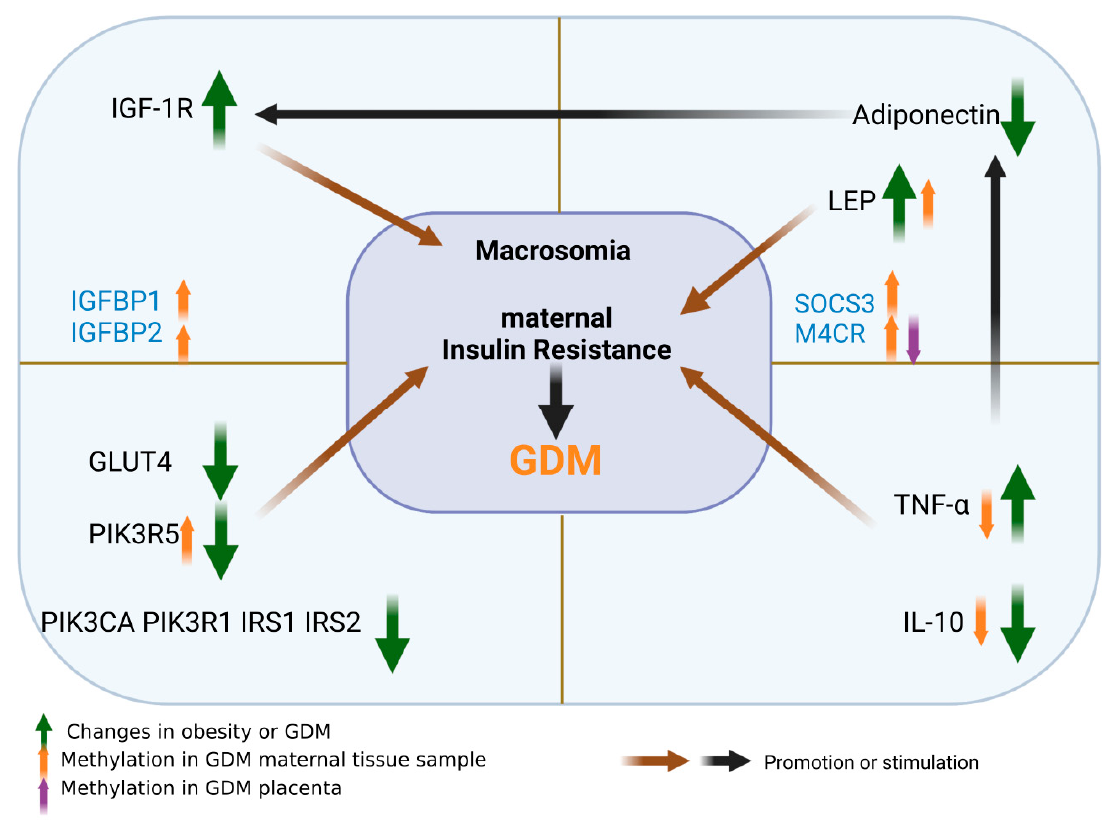
Figure 4. Role of various molecules and their methylation in the pathogenesis of GDM. The images in this figure were taken from https://biorender.com/ (accessed on 22 November 2022).